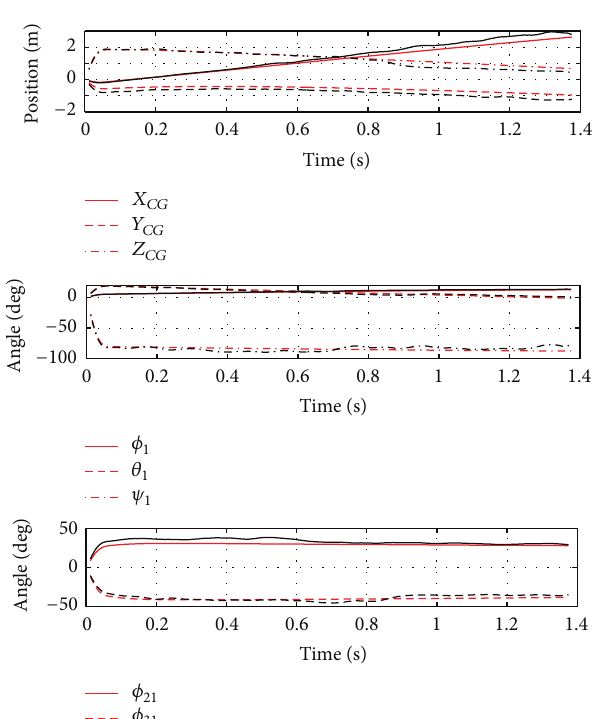
Figure 8: Flight test and model simulation comparison for gliding articulated MAV.